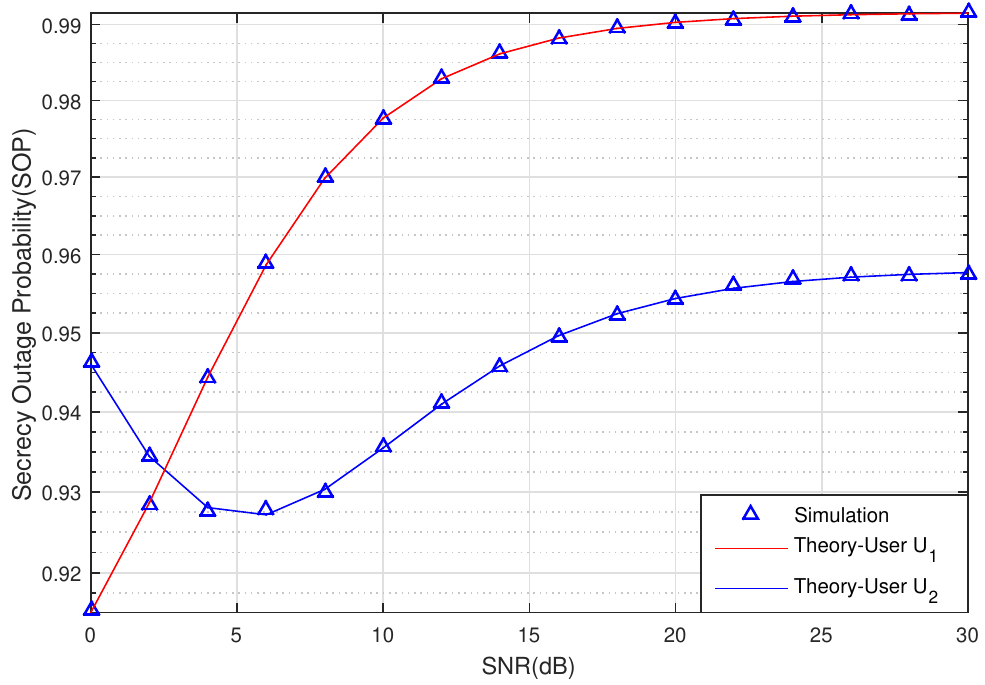
Figure 2. The SOP of U 1 and U 2 versus SNR (dB).